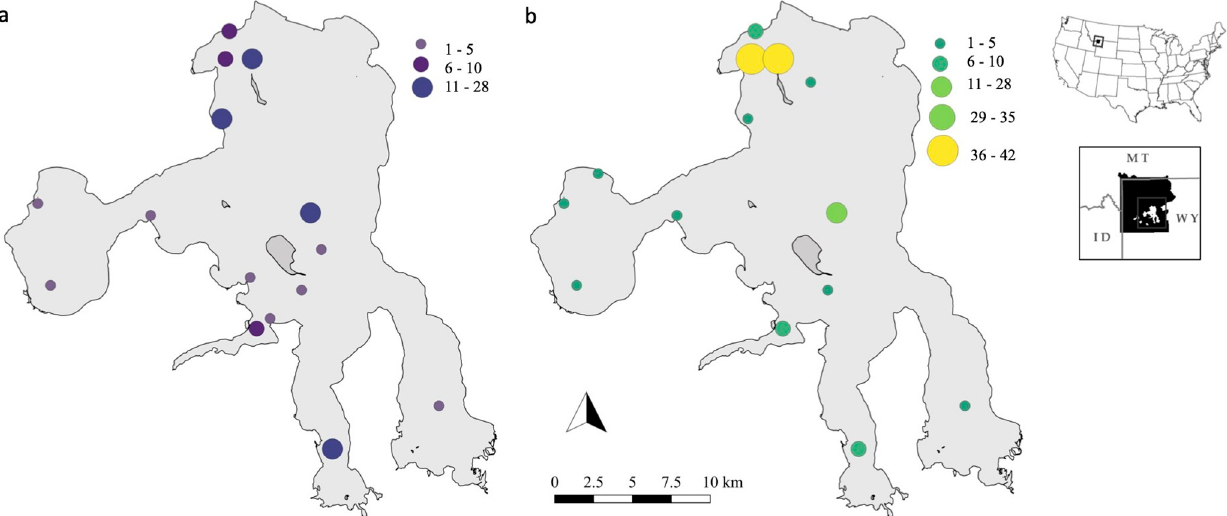
Fig 2. Distribution of samples collected from Yellowstone Lake. Map of Yellowstone Lake, Yellowstone National Park, Wyoming, USA showing the number and location of stable isotope samples and corresponding diet samples for Yellowstone cutthroat trout (a, purple hues) and lake trout (b, green hues) collected in 2018 and 2019. Base map sources can be accessed using the following: Yellowstone Lake border (https://pubs.usgs.gov/sim/2007/2973/); United States of America and individual state borders (https://www.sciencebase.gov/catalog/item/52c78623e4b060b9ebca5be5); Yellowstone National Park border (https://www.sciencebase.gov/catalog/item/4ffb3aebe4b0c15d5ce9fc0b).